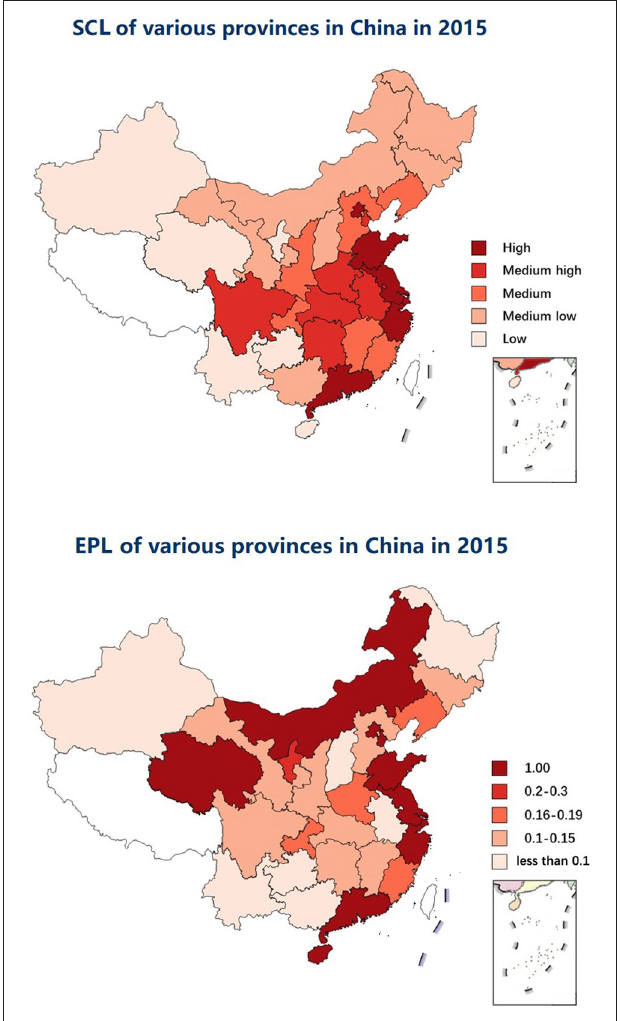
FIGURE 4 | Maps of SCL and EPL in China in